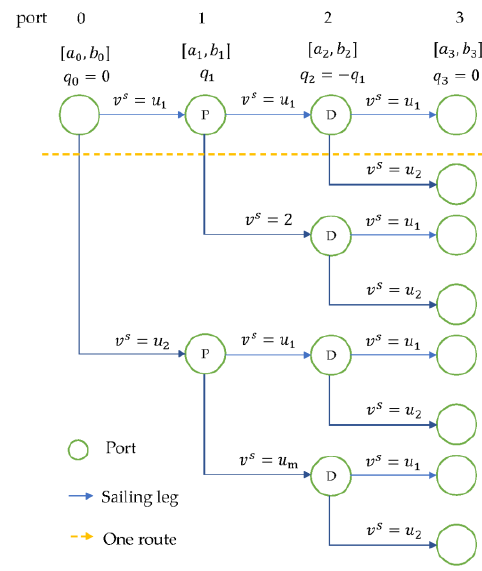
Figure 3. a simple example of the network. Figure 3. A simple example of the